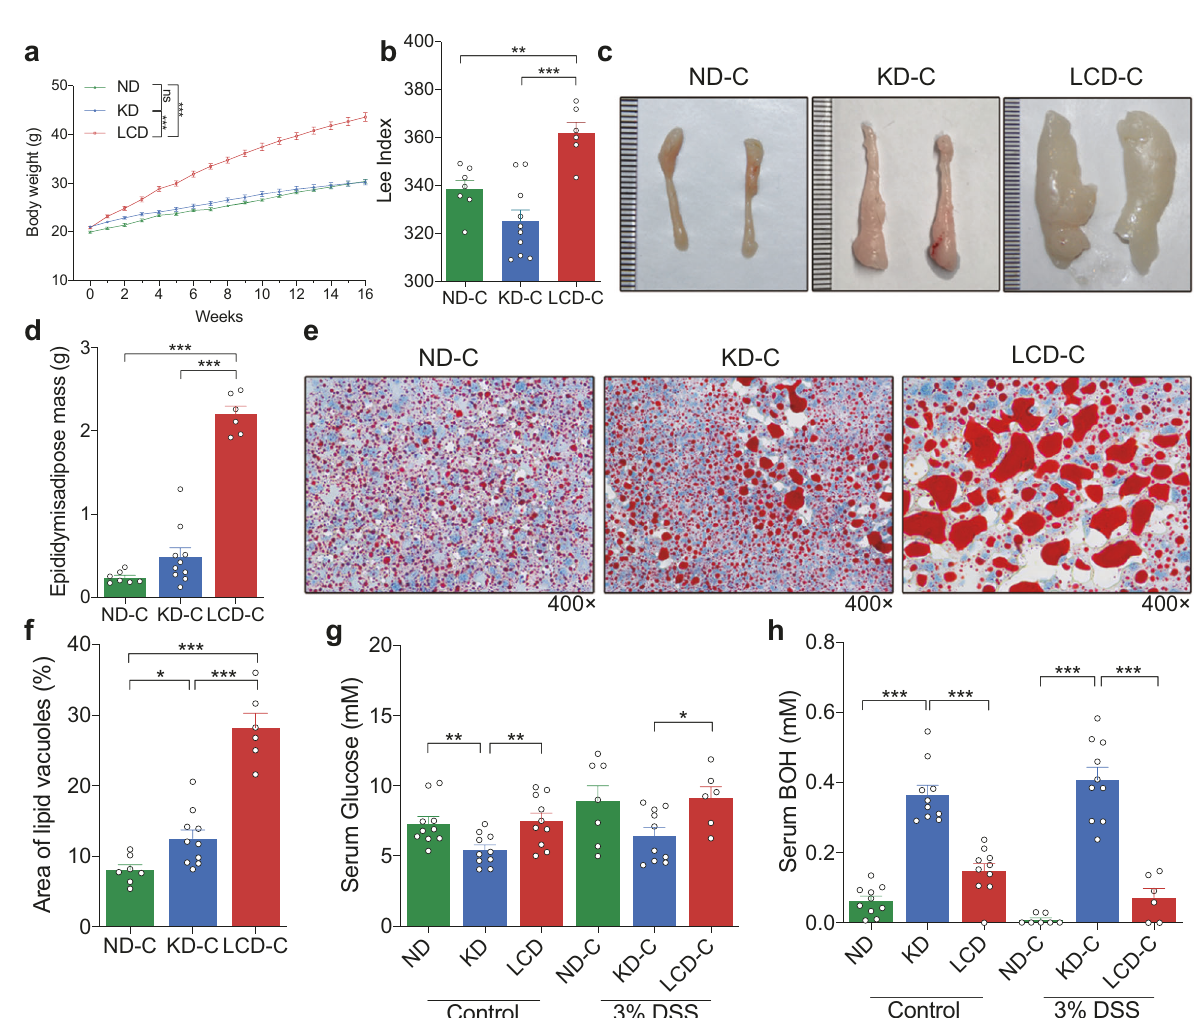
Fig. 1 KD contributes to bene fi cial gut microbiota and related metabolites in mice before colitis induction. a Schematic representation of study design. DSS-induced C57BL/6J colitis mice were fed with a KD, LCD, or ND and sacri fi ced at 17.5 weeks. DSS-induced C57BL/6J colitis germ-free mice received FMT from diet-treated mice and were sacri fi ced at 19 weeks. b , c α -diversity Chao1 ( b ) and Shannon indices ( c ) of mice fed with a KD, LCD, or ND for 16 weeks (* p < 0.05; ** p < 0.01). d PCoA scores based on the relative abundance of operational taxonomic units (97 % similarity). Each symbol represents a sample. e , f Dominant phyla ( e ) and genera ( f ) in each group. g Cladogram of linear discriminant analysis scores for differentially abundant bacteria (p: Phylum, c: Class, o: Order, f: Family). h Clustering analysis of different metabolites in each group. i Correlation heatmap of gut microbiota and metabolites ( + p < 0.05; * p < 0.01). ( n = 10 per group). Results are expressed as mean ± SEM ( b , c ). KD, ketogenic diet; LCD, low-carbohydrate diet; ND, normal diet; DSS, dextran sulfate sodium; FMT, fecal microbiota transplantation; PCoA, principal component analysis